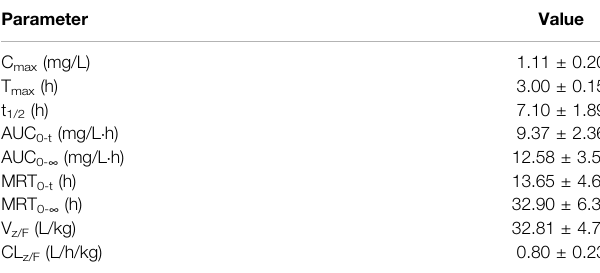
TABLE 4 | Primary pharmacokinetic parameters of anwulignan in mice after the intragastric administration of anwulignan. Parameter